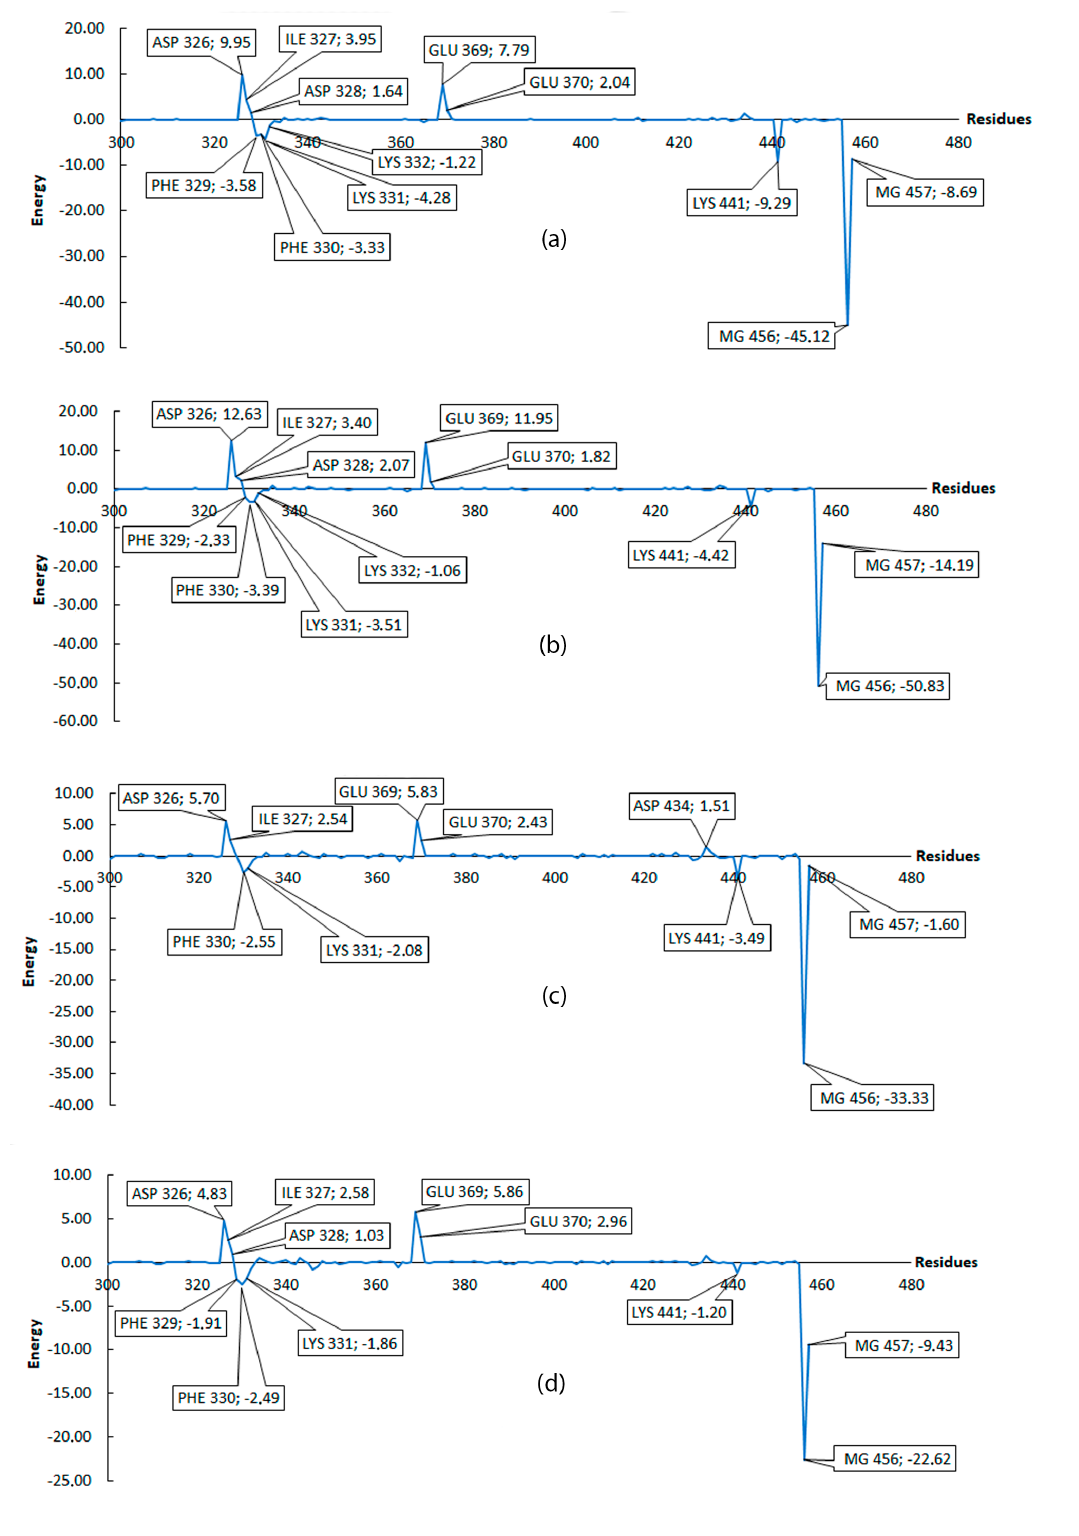
Figure 6. Interaction per residue from residue 300 to 457. All energies were calculated in kcal/mol. ( a ) Ligand3, ( b ) Ligand4, ( c ) Ligand5, and ( d ) Ligand6. Residues with contribution higher than 1 or lower than − 1 are